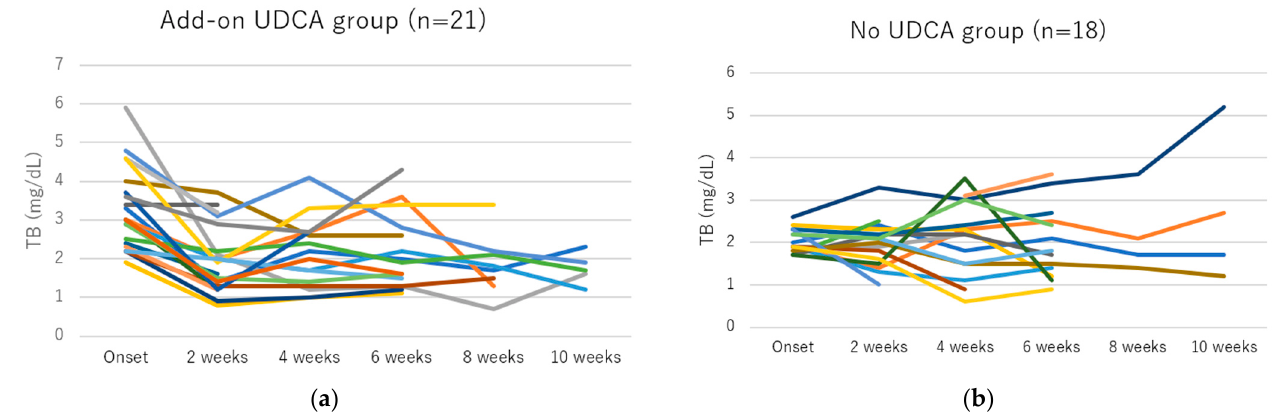
Figure 1. Changes in total bilirubin (TB) for individual patients with hyperbilirubinemia grade ≥ 2. ( a ) TB decreased significantly in the add-on ursodeoxycholic acid (UDCA) group ( p < 0.05). ( b ) No significant change in TB was seen in the no UDCA group. Change of each patients’ TB value was expressed using different color lines. Table 6. Comparison of total bilirubin changes between with and without add-on ursodeoxycholic acid groups.